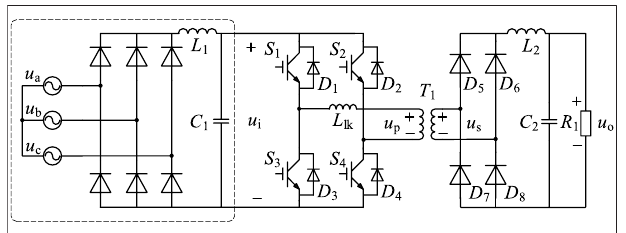
FIGURE 1 | Topology structure of the